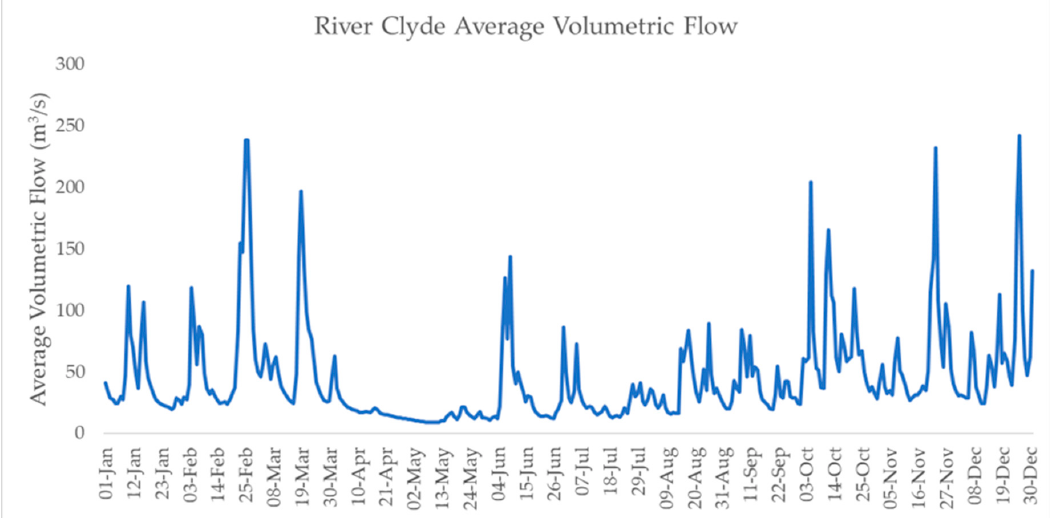
Figure 8. River Clyde average daily volumetric flow at Daldowie for 2017.